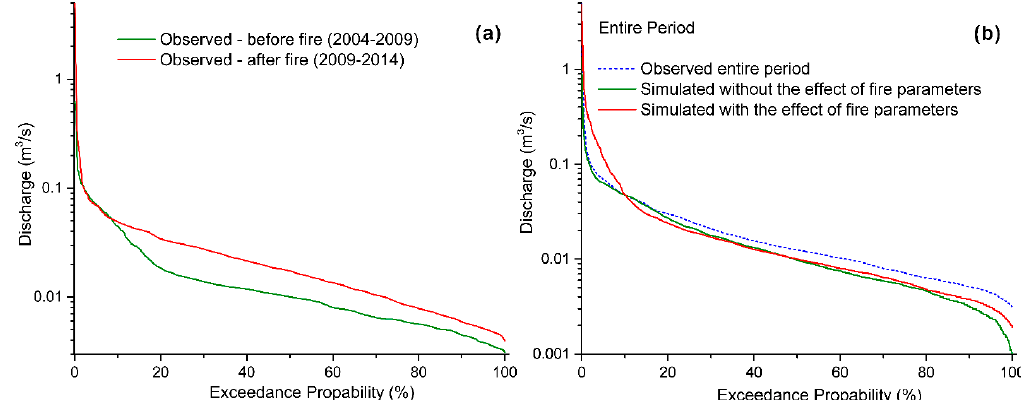
Figure 4. Flow duration curves calculated from the ( a ) daily observed discharges before and after the fire incident and ( b ) daily observed and simulated discharges for the entire period. In Figure 5, the monthly runoff depth temporal distribution against the monthly pre- cipitation depth is presented. As can be seen the simulated runoff depth with the pre-fire model configuration follows the observed one during the pre-fire period (until Aug 2009), but it is lower than that during the post-fire period (from Sep 2009). The opposite behavior